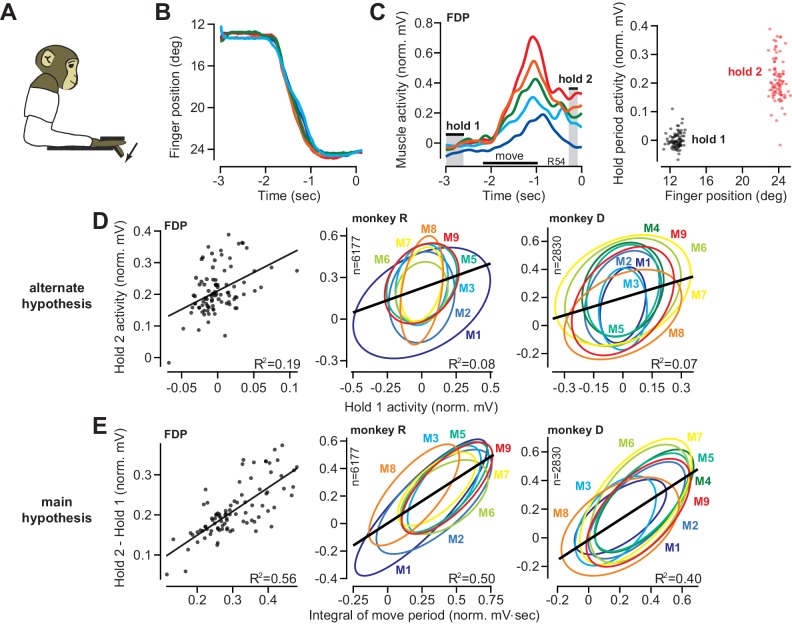
The integral of muscle activity during finger flexion correlates with subsequent activity during the hold period.(A and B) Monkeys were trained to move their index finger from an initial position to a target against a load. The traces show representative movements. Positive displacements correspond to flexion. (C) Activity of flexor digitorum profundus (FDP) in monkey R. Left panel shows FDP activity for the trials shown in (B). The bars for hold 1 and hold 2 indicate periods was hold activity was calculated. Right panel shows FDP activity during the hold periods. Activity increased with flexion of the finger, but was variable from one trial to the next. (D) Evaluation of the hypothesis that variability in muscle activity at the hold 2 position could be explained by variability in the preceding hold 1 activity. Left panel is for the FDP muscle during a single session in monkey R. Center and right panels present data across all muscles recorded in each monkey. Each ellipse is the 95% confidence interval for a single muscle. R2 value refers to a linear fit across all trials and muscles. (E) Same as for (D), except here we test the hypothesis that variability in hold period activity is related to the integral of the preceding moving activity.Figure 2—source data 1.The EXCEL source data file contains holding EMG activity and the integral of moving EMG activity for all muscles shown in Figure 2.The data provide trial-by-trial measures of each quantity. In addition, the position of the finger during hold 1 and hold 2 are provided for all trials in each session. The ‘readme’ tab describes all quantities reported in the ‘data’ tab.